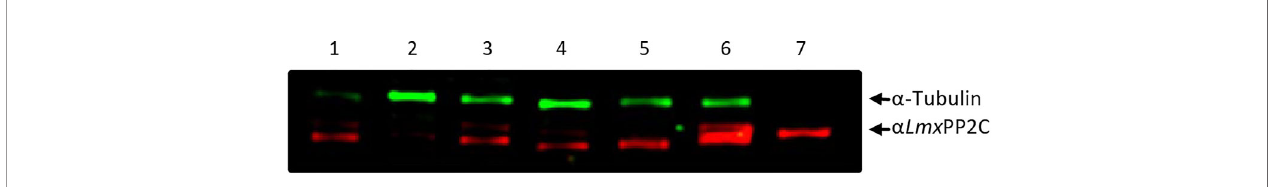
FIGURE 2 | Identi fi cation of PP2C in the total extract of promastigotes of different species of Leishmania . Immunodetection of the PP2C protein in the total extract (TE) of the promastigotes of L . (V.) panamensis MHOM/PA/71/LS94 (lane 1) , L. (V.) brazilienzis MHOM/BR/75/M2903 (lane 2), L. ( L. ) venezuelensis MHOM/VE/80/ PMH3 (lane 3), L. (V.) donovani (lane 4), L. ( L. ) amazonensis IFLA/BR/67/PH8 (lane 5), and L. (L. ) mexicana MNYC/BZ/62/M379 (lane 6). Lmx PP2C (lane 7) served as the control and tubulin as a loading control.